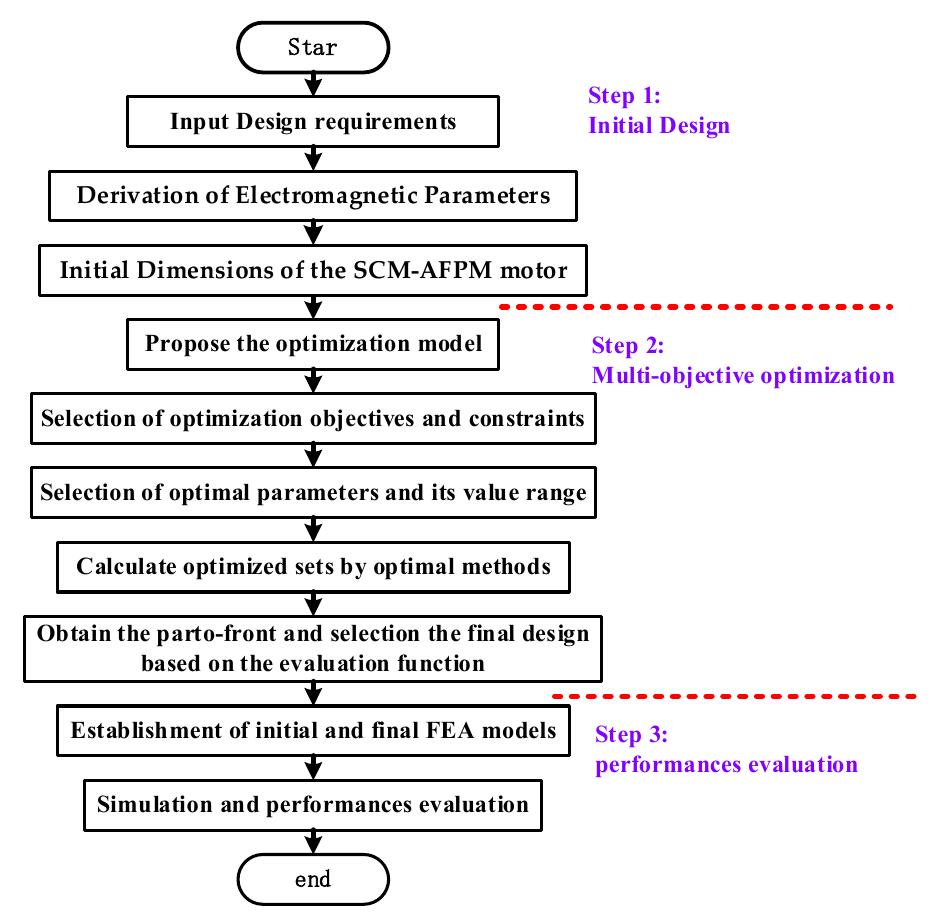
Figure 2. Flowchart of the multi-objective optimal design.